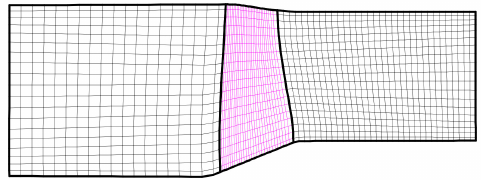
Figure 13. The meridian grid of the fan calculation domain.